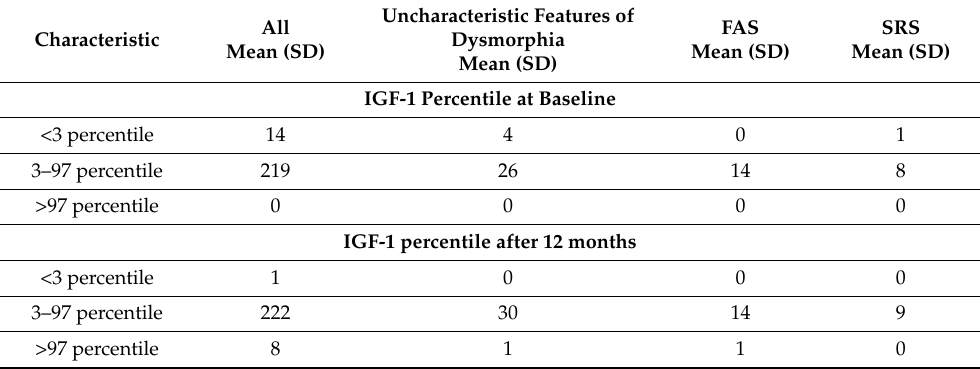
Table 6. Percentile values of IGF-1 in different